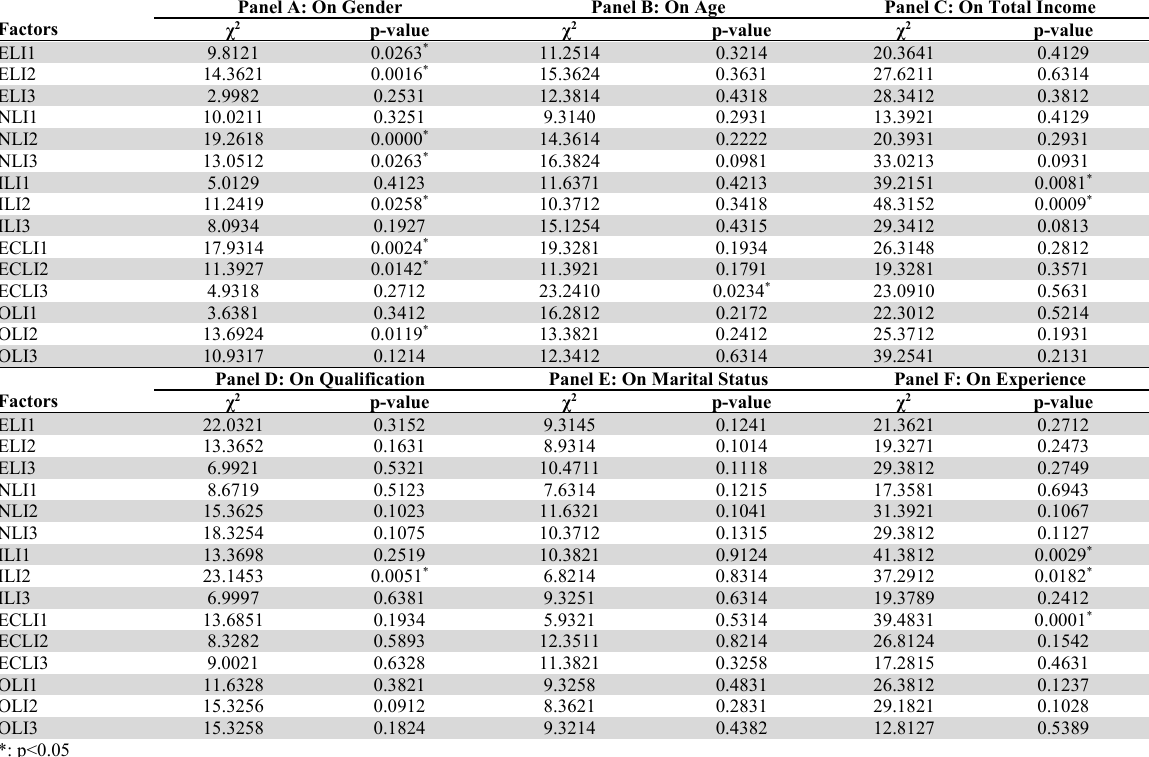
Outputs of Chi-square Test and Cross-Tab Analysis of each dimension of Talent Turnover on Demographic Variables “ Panel A: On Gender Panel B: On Age Panel C: On Total Income Factors” χ 2 “p-value” χ 2